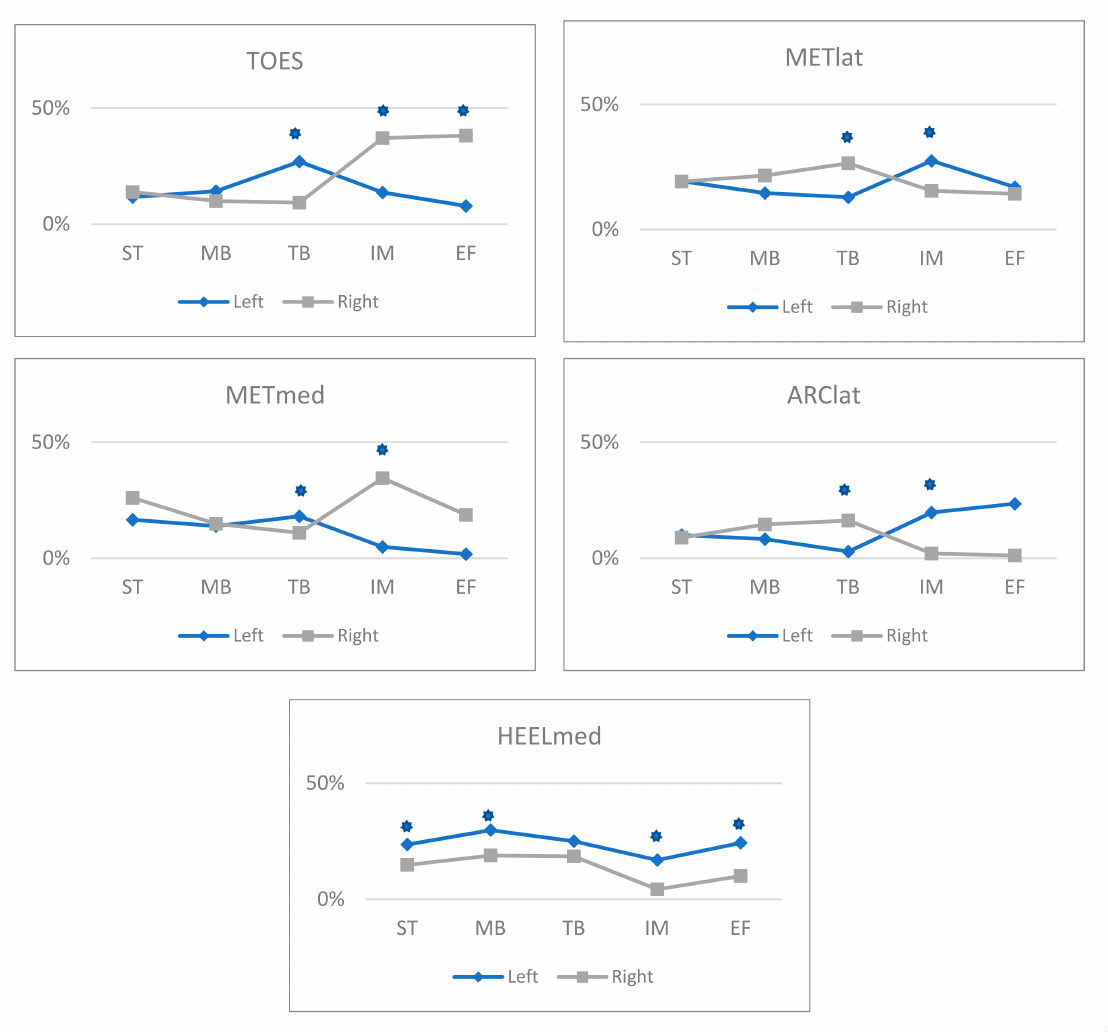
Figure 5. Comparison of the normalized pressure for the Professional Players during the swing in the left and right foot. ( ): Significant difference ( p <